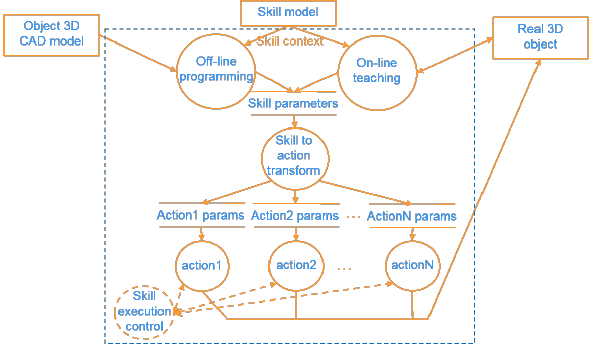
Figure 4: Skill programming can be done off-line based on geomet- ric models or on-line based on sensor data